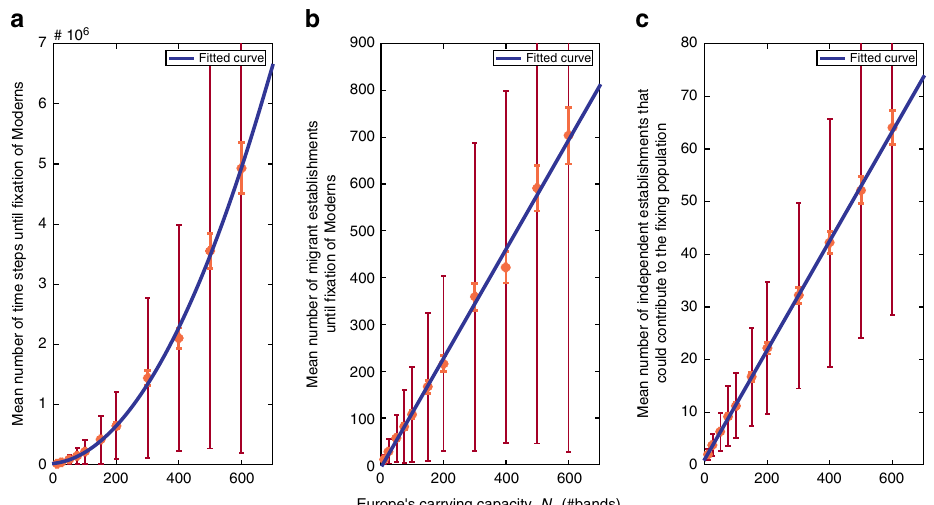
Fig. 1 The time and number of successful migrations until species replacement. a Mean number of simulation time steps until complete replacement of Neanderthals by Moderns. Here and in ( b ) and ( c ), orange error bars denote two standard errors around the mean, and brown bars denote the standard deviation; 500 replicate simulation runs were conducted with each carrying capacity value. The dark blue line is a fi t of the means to a quadratic function, demonstrating that the number of time steps to fi xation scales with ( N 1 ) 2 . b The mean number of migrant establishments in Europe that take place until replacement occurs is linearly related to N 1 . Here and in ( c ) the dark blue line is a fi t to a linear function. c The number of migrant establishments that occur while the Moderns are segregating in Europe on their way to fi xation scales with N 1 . For all panels, the probability of migration into Europe per time step, M = 0.1 ( N = 100, m = 2 2 2